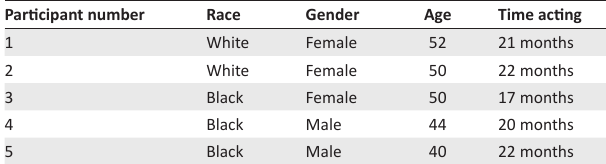
TABLE 1: Demographics of the study